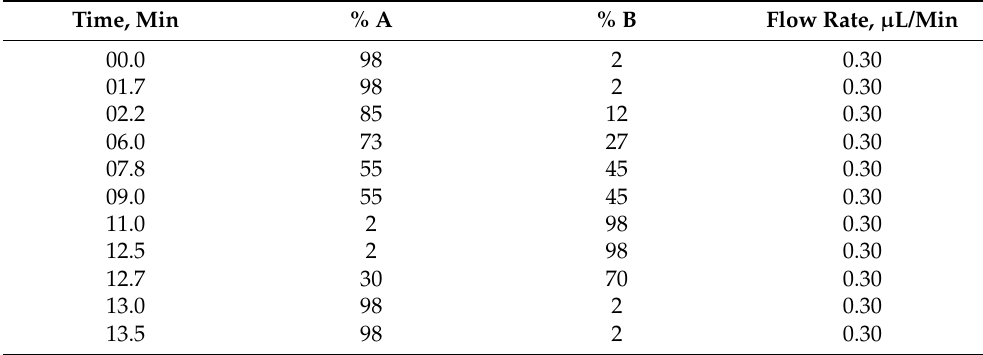
Table 3. Scheme of the elution of amino acids from a chromatographic column Zorbax RRHD Eclipse Plus